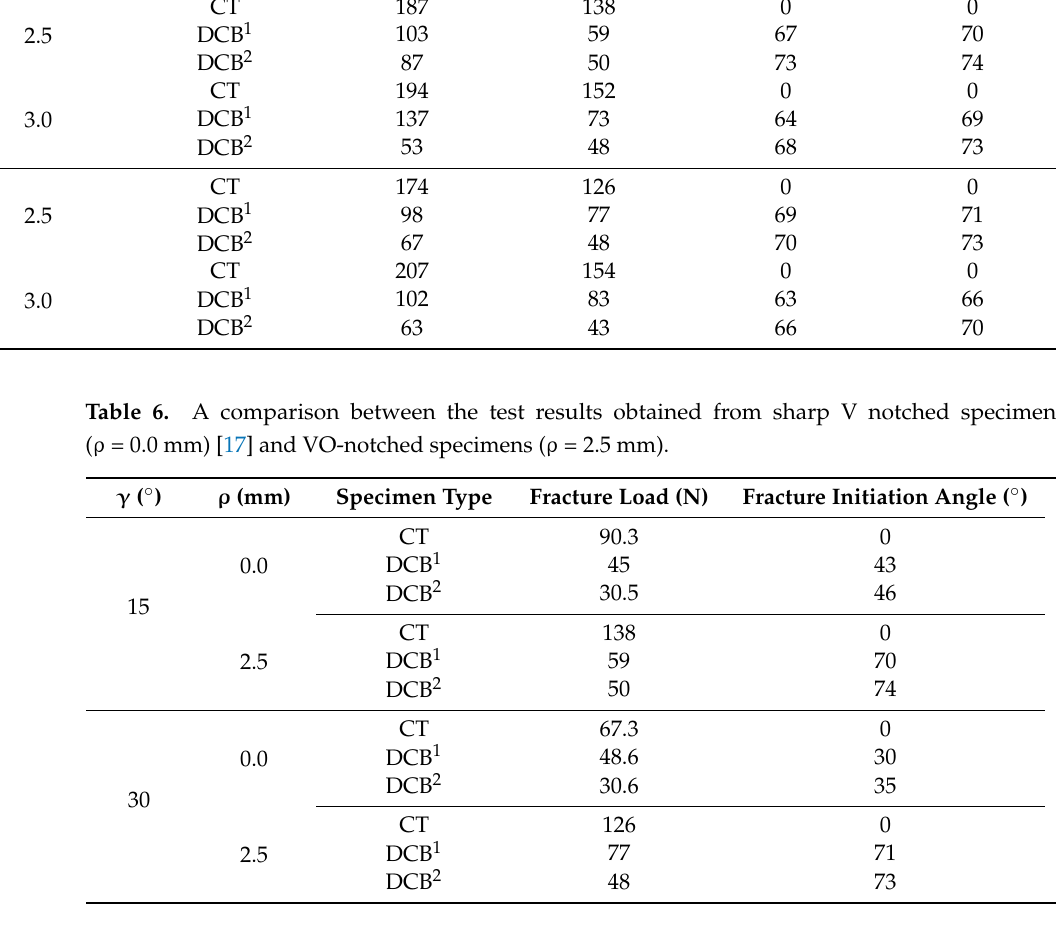
Table 5. Mode I loading test results of blunt V-notched specimens and VO-notched specimens. γ ( ◦ ) ρ (mm)